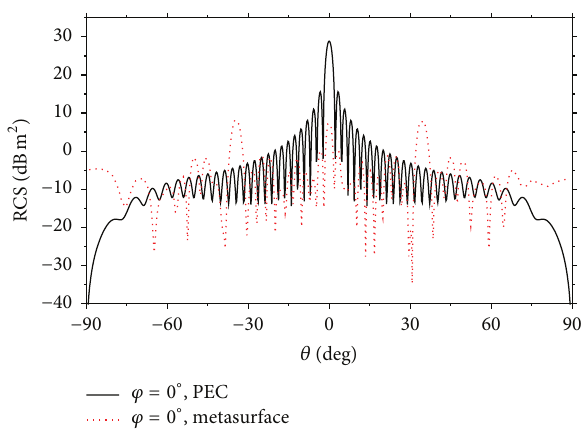
Figure 14: Comparison of the bistatic RCS at 17 GHz along 𝑥𝑜𝑧 plane for the metasurface and the PEC plate.